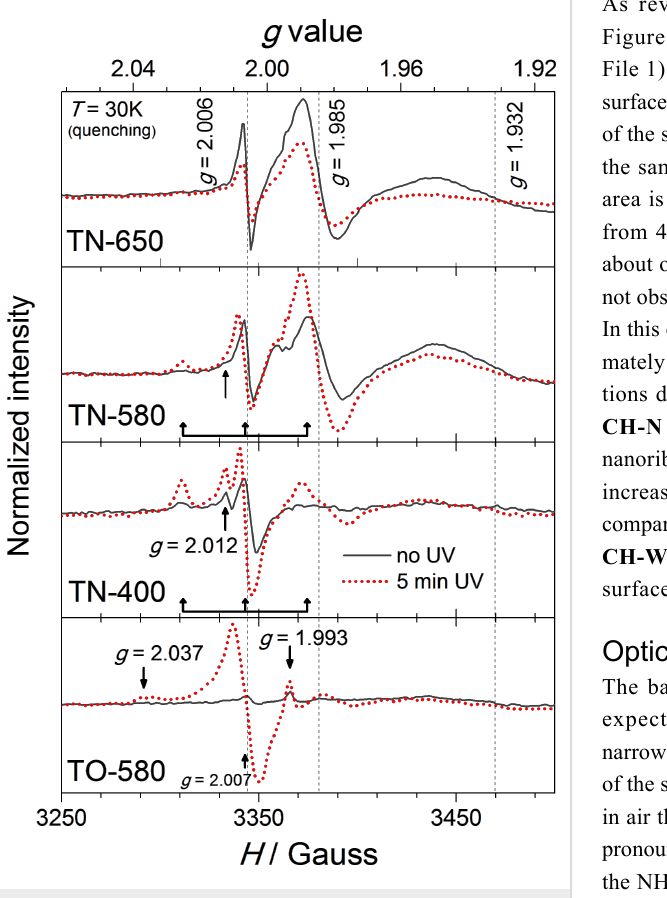
Figure 9: EPR spectra of TiO 2 nanoribbons derived from hydrogen titanate nanoribbons by calcination in an NH 3 (g)/Ar(g) flow ( TN-650 , TN-580 and TN-400 ) and air ( TO-580 ) measured in darkness (grey lines) and after 5 min of UV–vis illumination (red dotted lines). Samples were quenched from room temperature to 30